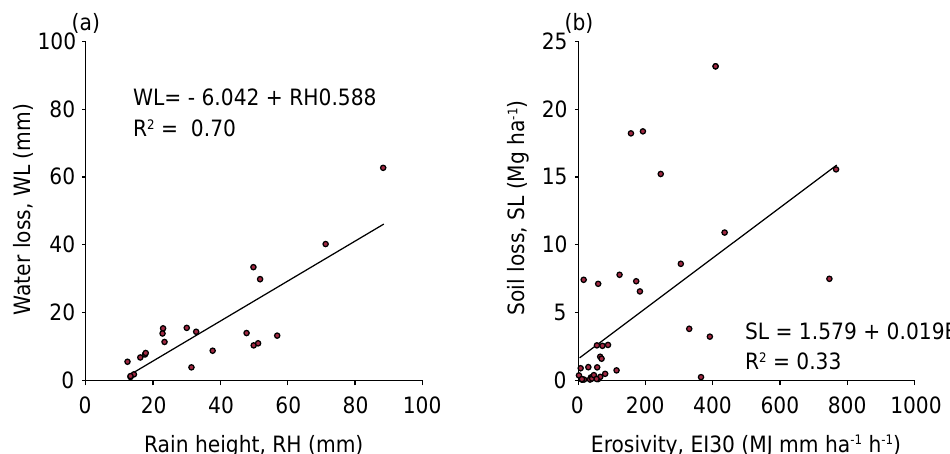
Figure 1. The relation between (a) values of water loss (WL) and rain height (RH) (p<0.01) and (b) values of soil losses (SL) and erosivity (EI 30 ) (p<0.05) (individual values of each variable and average of the